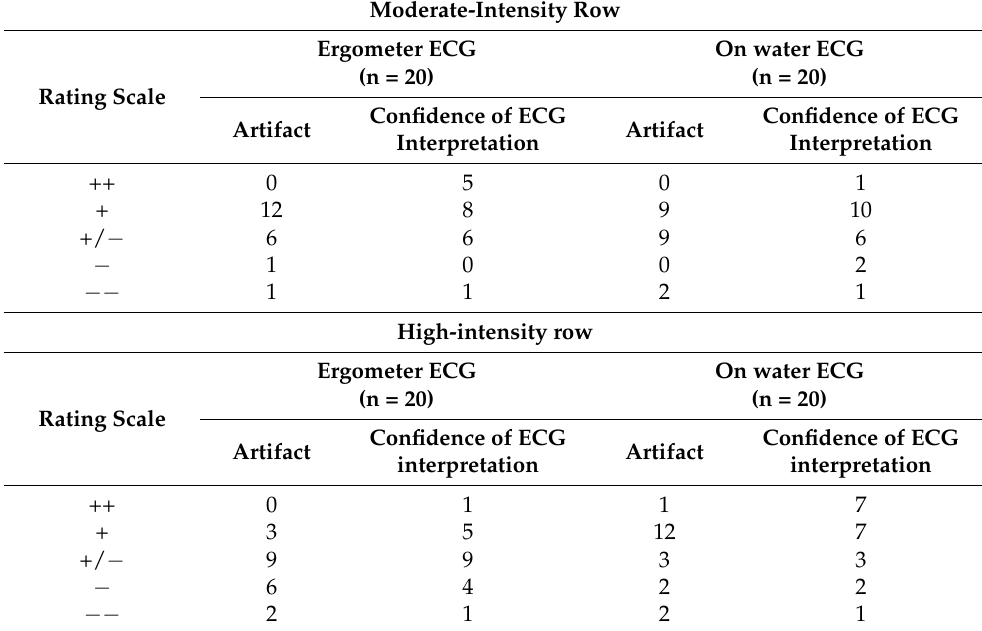
Table 4. Quality rating of